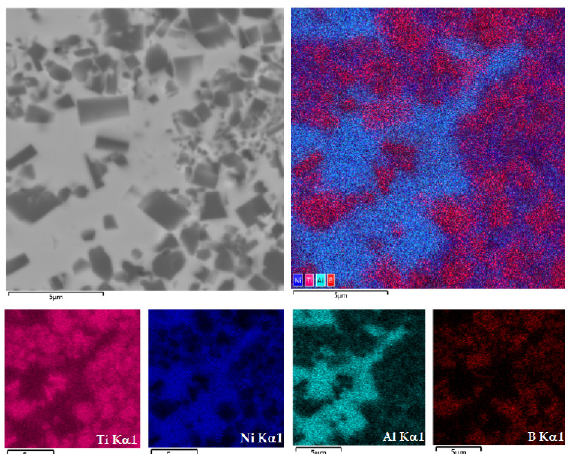
Figure 6. SEM image of a local area of a composite SHS powder particle (Figure 5, area 3) and maps of the distribution of chemical elements in a local area of a composite particle.